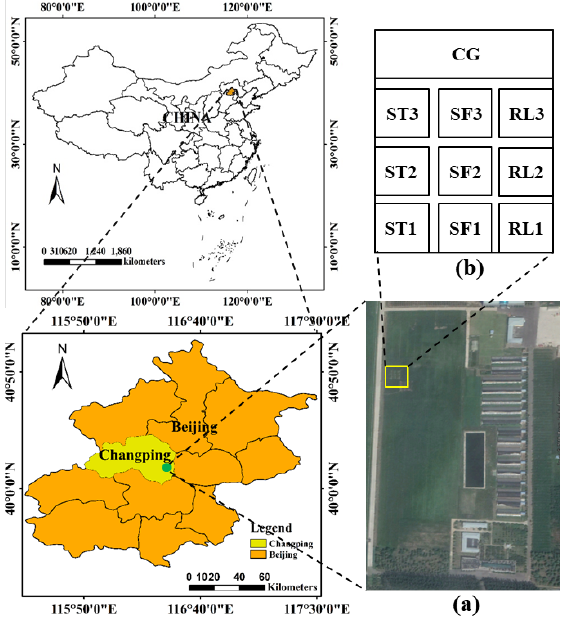
Figure 1. Study area location and experimental design. ( a ) Experimental area location. ( b ) Experimental